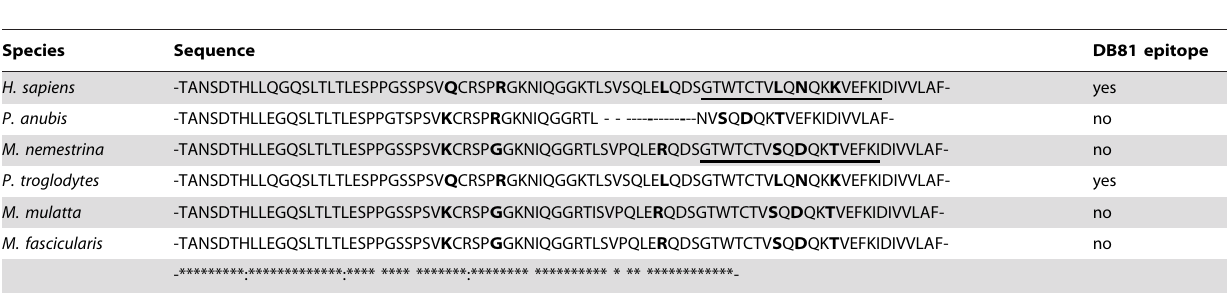
Figure 4. Membrane expression of the DB81 epitope. A . Cytofluorimetric analysis of MAb DB81 binding to RK13 cells expressing HIV-1 Ba-L and treated or not with soluble CD4. A FITC-conjugated, affinity purified polyclonal antibody to mouse IgG was used as a secondary reagent. The blue line shows background binding of the secondary antibody; the red line shows binding of MAb DB81 to untreated cells; the green line shows binding of MAb DB81 to cells pre-treated with 2D-CD4. B. Cytofluorimetric analysis of MAb DB81 binding to RK13 cells expressing HIV-1 Ba-L and treated or not with a CD4 miniprotein (CD4-M3). A FITC-conjugated, affinity purified polyclonal antibody to mouse IgG was used as a secondary reagent. The blue line shows background binding of the secondary antibody; the red line shows binding of MAb DB81 to untreated cells; the green line shows binding of MAb DB81 to cells pre-treated with CD4-M3. C, D. Cytofluorimetric analysis of MAb DB81 binding to PM-1 cells treated or not with HIV-1 gp120. A FITC-conjugated, affinity purified polyclonal antibody to mouse IgG was used as a secondary reagent. The blue line indicates background binding of the secondary antibody; the red histogram shows binding of MAb DB81 to untreated PM-1 cells; the green histogram shows binding to PM-1 cells pre-treated with recombinant gp120 Ba-L ( C ) or recombinant gp120 IIIB ( D ), respectively. doi:10.1371/journal.pone.0022081.g004 Table 2. Sequence alignment of segment 126-204 from the second Ig-like domain of the CD4 molecule from different primate